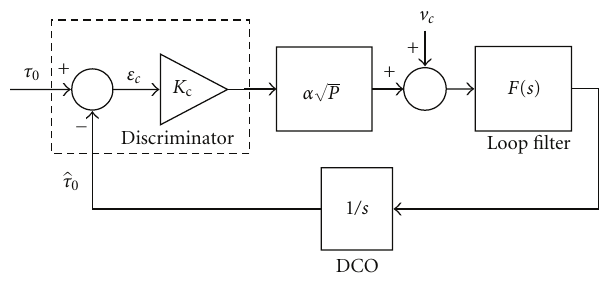
Figure 3: Linearized